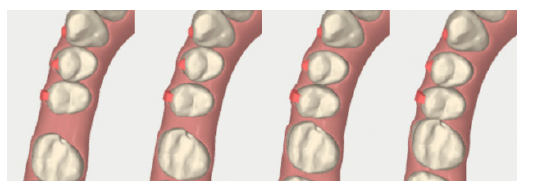
Figure 16. Case 2: digital sequential (left to right) detail of the facilitated space closure orthodontic movement.